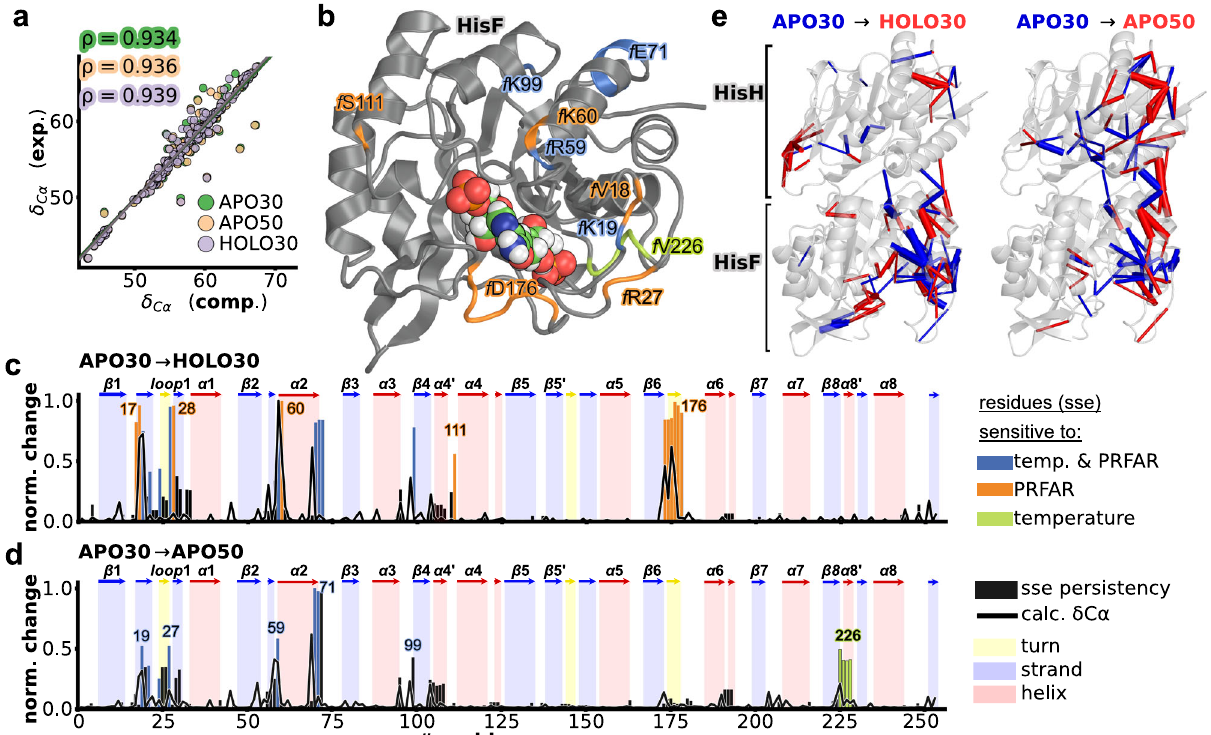
Fig. 3 | Correspondence between dynamics from the MD trajectories and sec- ondarystructurechanges.a CorrelationbetweencomputedaverageC α chemical shifts obtained by employing SHIFTX2 92 computations over apo30 (green), apo50 (purple) and holo30 (pale orange) MD simulation runs and corresponding values obtained experimentally. Pearson correlation values are shown on the top left outlined with matching colors. b Cartoon representation of HisF, with selected residuescoloredaccordingto( c )and( d ). c ChangeinaverageSHIFTX2 92 simulated C α chemicalshift(solidblackline)calculatedfrom apo30 to holo30